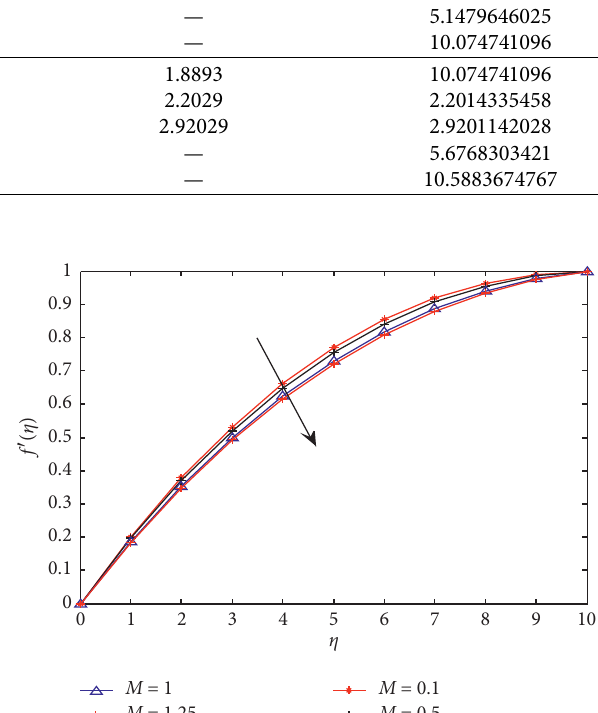
Figure 2: Velocity profile for numerous values of M when